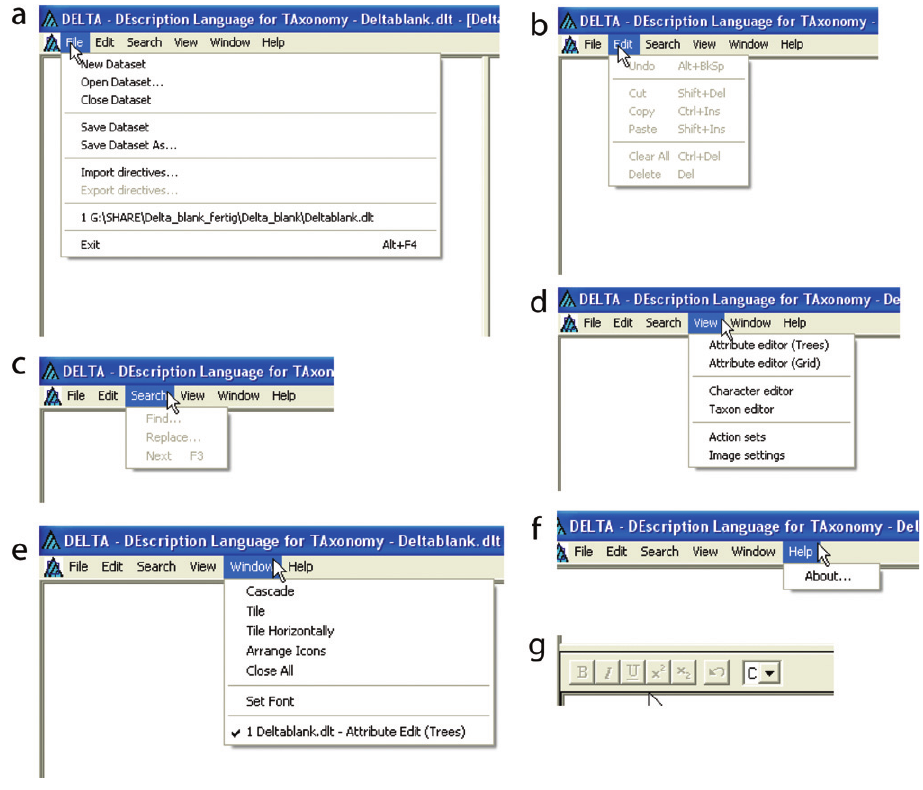
Figure 2a–g. Dropdown menus of the DELTA Editor.